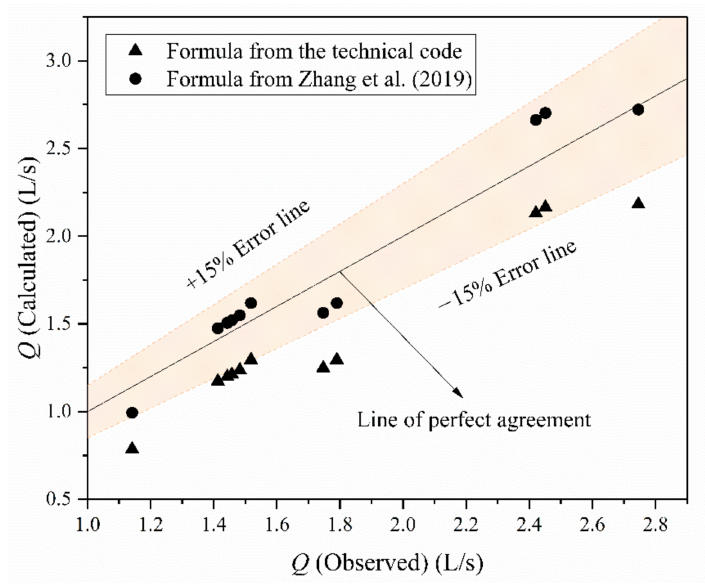
Figure 6. Comparison of the calculated discharge and the observed